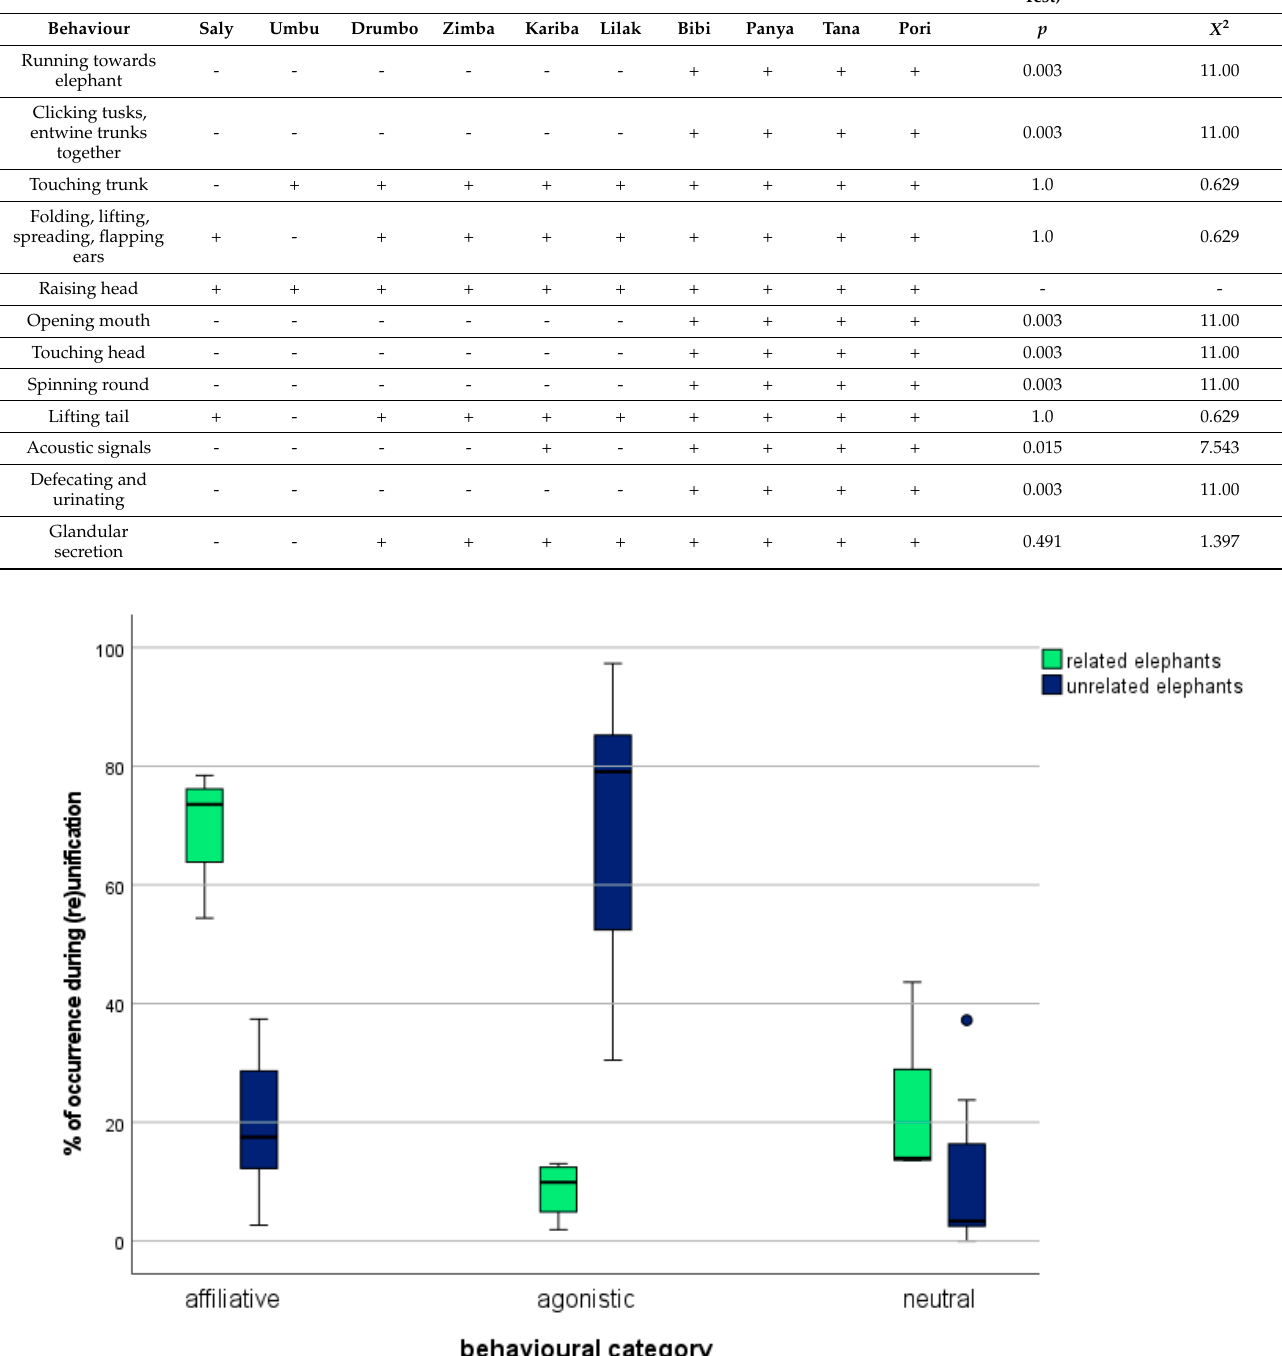
Figure 1. Percentage of affiliative and agonistic behaviours of the total behaviour shown by related and unrelated elephants during (re)unifications.